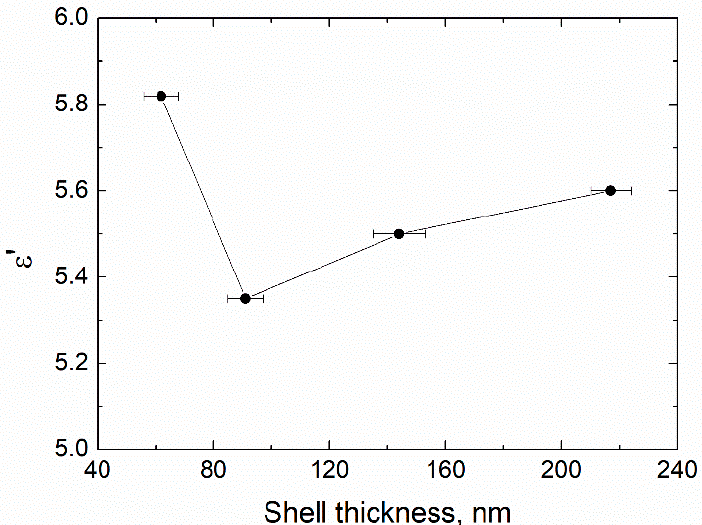
Figure 15. Quasi-static real part of permittivity vs. thickness of the shell that was obtained by varying ammonia concentration.